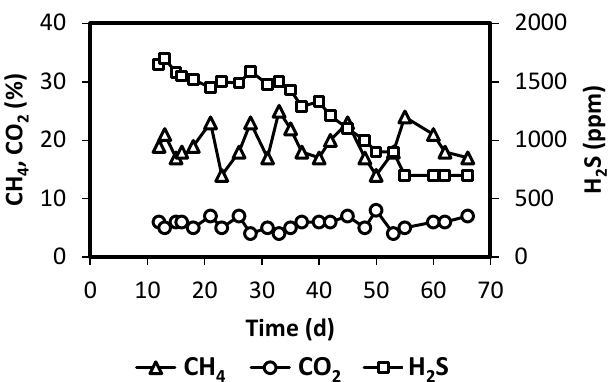
Figure 4. Concentration of sulfide in oxygen container for the Reactor 2 system.